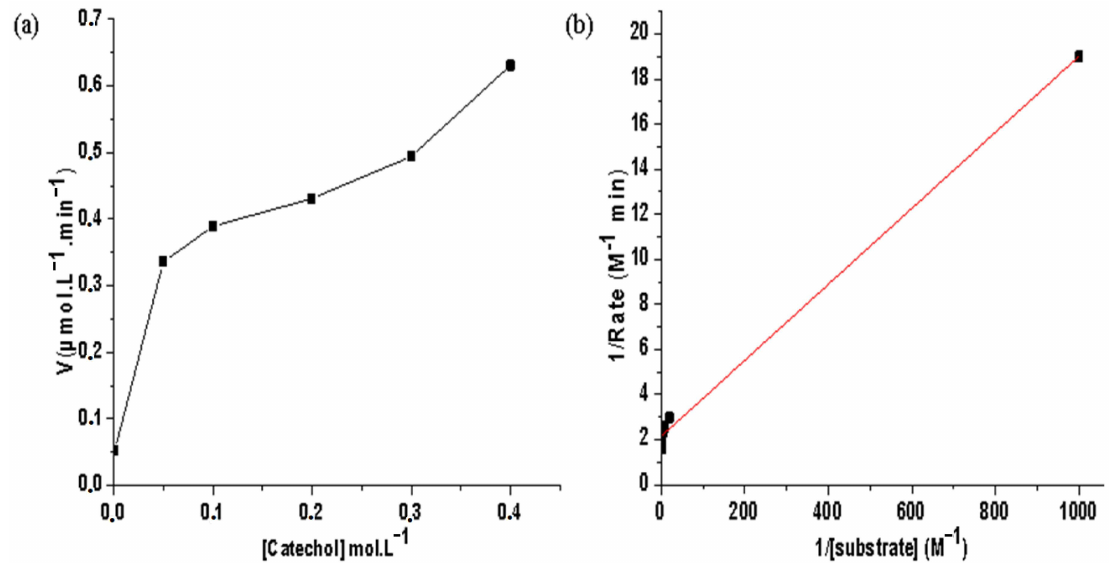
Figure 7. Co(II)/pyrazole catalyzed catecholase of o-quinone in a MeOH and open O 2 -RT condition: ( a ) Michaelis–Menten correlation, and ( b ) Lineweaver − Burk